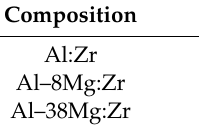
Table 1. The mass of fuel needed to consume 100% of available O 2 in the calorimeter, assuming 1 atm of O 2 , complete combustion, and ideal gas behavior in a calorimeter with a volume of 15 cm 3 . Composition Mass (mg) Al:Zr 44.76